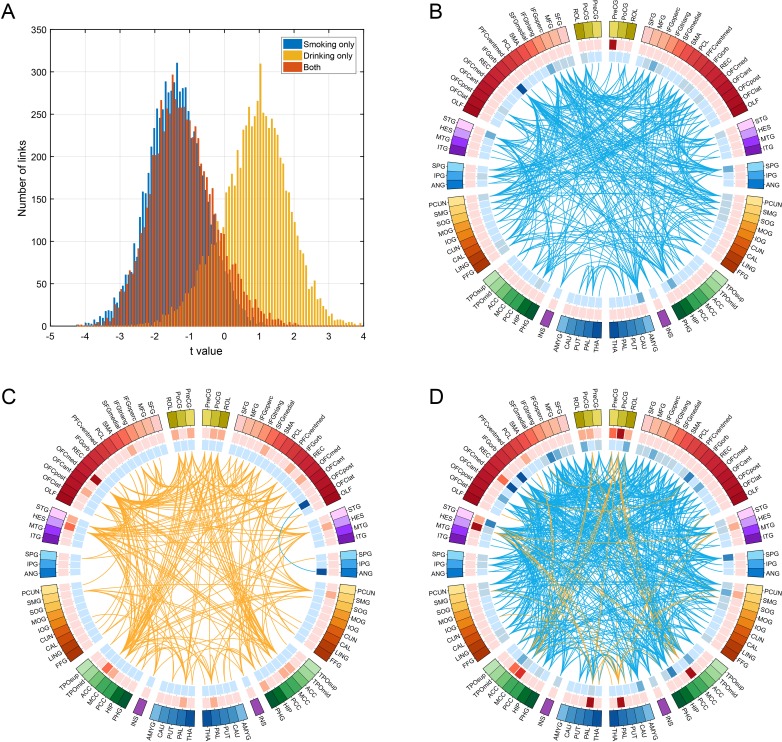
Comparison of functional connectivity in three groups (i.e smoking only n = 60, drinking only n = 219, and both smoking and drinking n = 143) using a common baseline comparison group (a no smoking and low drinking group n = 198) from the HCP dataset.(A) shows the distribution of t values of all the links for all AAL2 areas for the three comparisons. A positive t value indicates a stronger FC in a substance use group compared to the control group. For B-D, only the significantly different links identified in the HCP dataset as shown in Figure 3 are considered. (B) shows that all these links are decreased in the smoking only group. (C) shows that all these links are higher in the drinking only group. (D) shows that there are both higher and lower links in the group that both smokes and drinks.10.7554/eLife.40765.014Figure 4—source data 1.For the FC links identified as involved in smoking: comparison of functional connectivity between three groups: smoking only; drinking only; and both smoking and drinking.10.7554/eLife.40765.015Figure 4—source data 2.For the FC links identified as involved in drinking: comparison of functional connectivity between three groups: smoking only; drinking only; and both smoking and drinking.